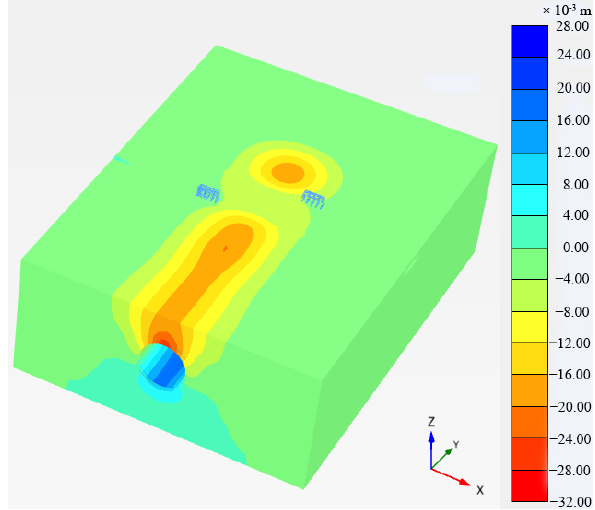
Figure 8. Map of the entire model settlement.